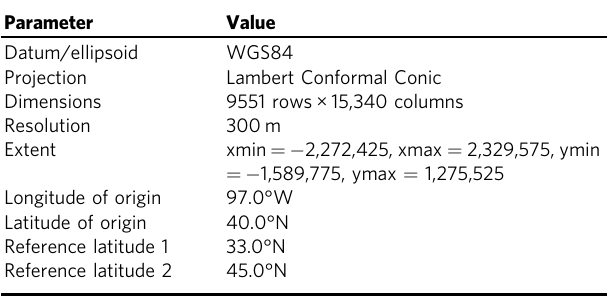
Table 3 Parameter values for the 300 m grid used to intersect Vulcan emissions with urban